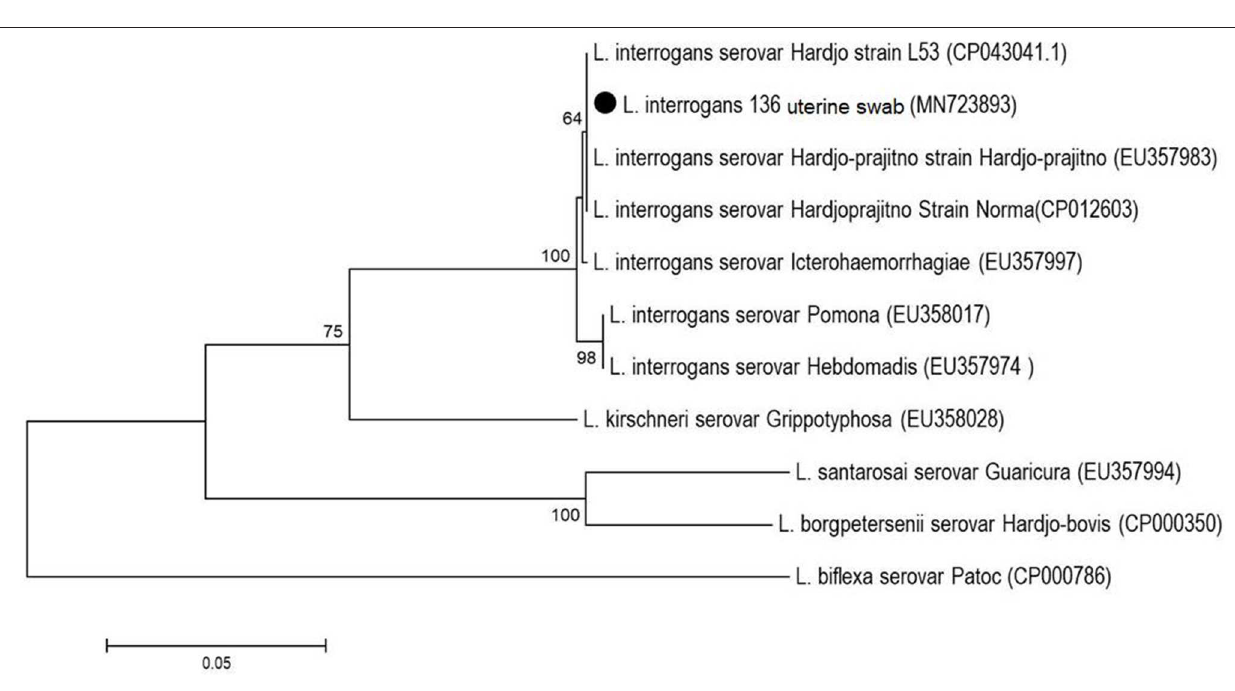
Frontiers in Veterinary Science | www.frontiersin.org